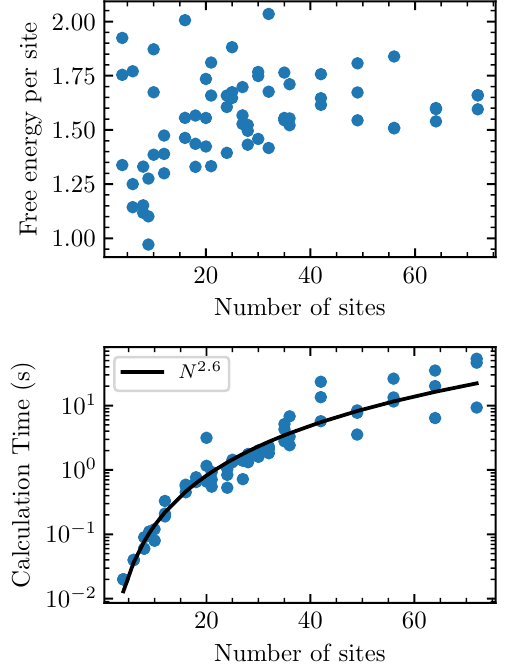
Figure 29: The free energy per site from PyTNR (top), residual versus the asymptotic value (middle) and computation time (bottom) for the 2D Ising model on a square lattice with open boundary conditions and disordered h and J is shown as a function of the number of sites N . The lattice dimensions were chosen to have aspect ratios no greater than 3 and to cover a range of N without large